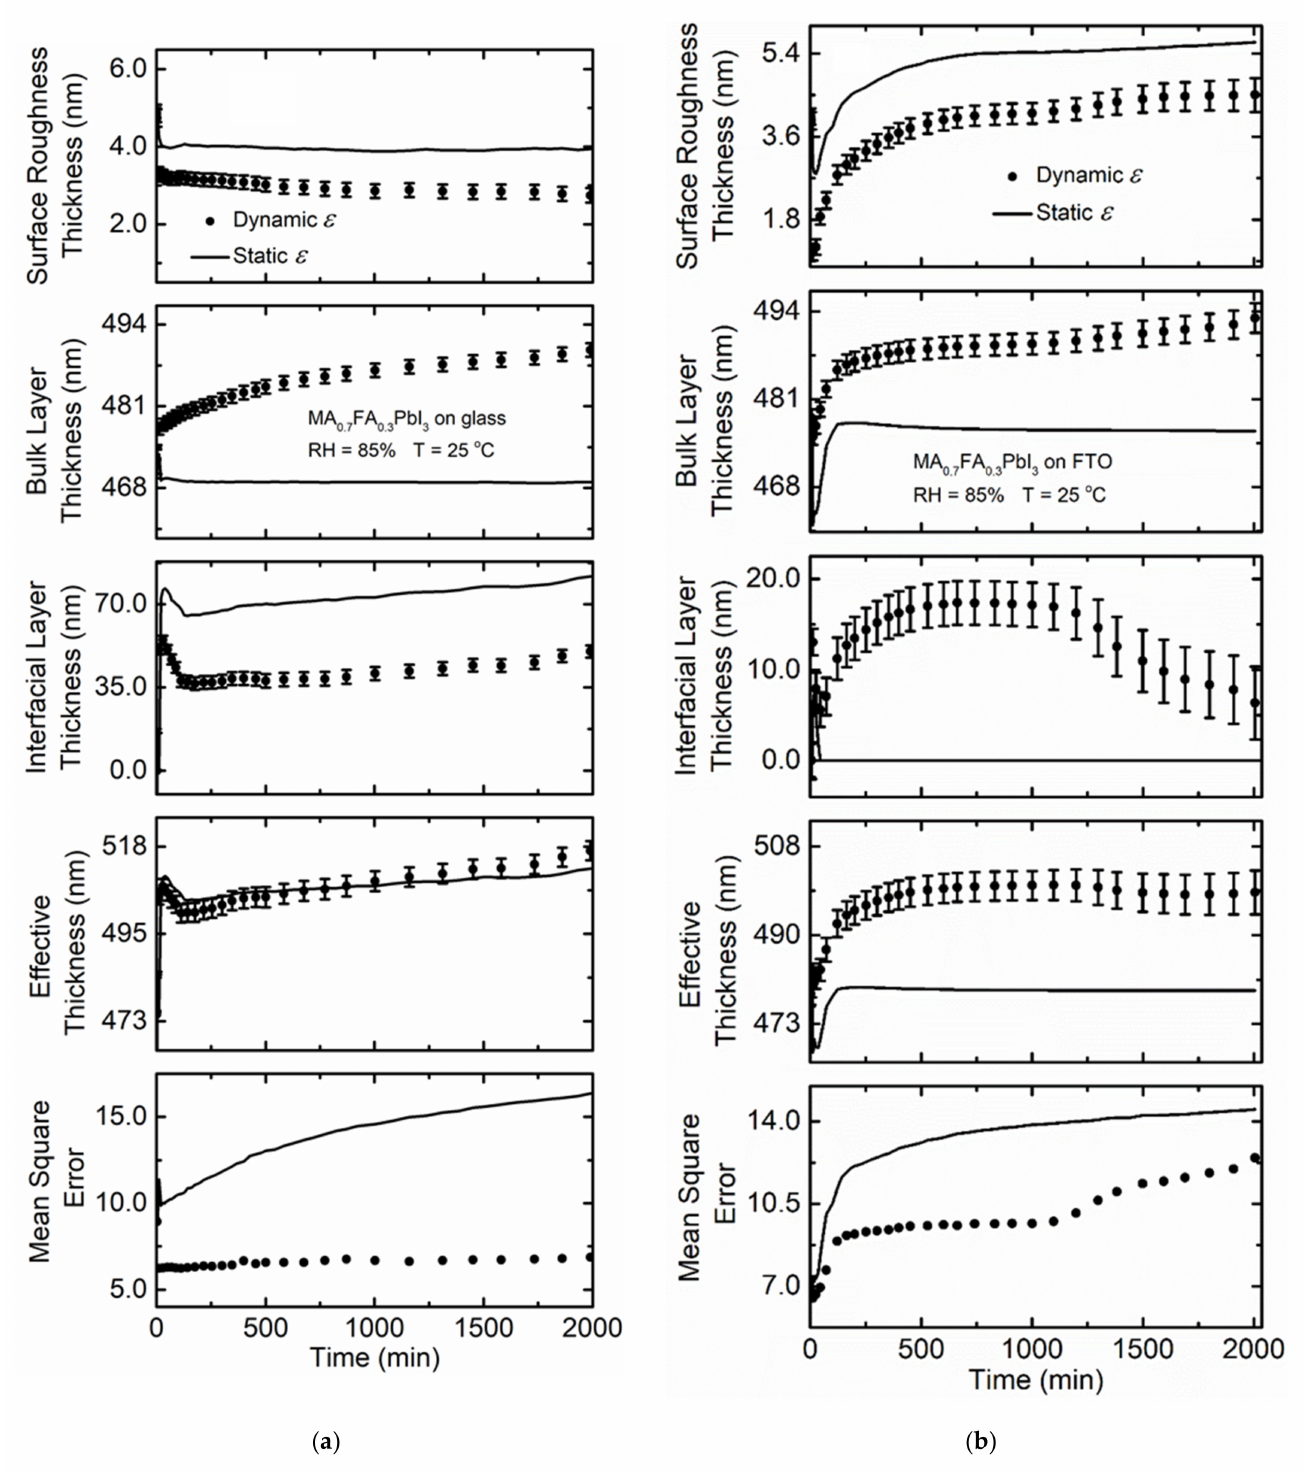
Figure 5. Surface roughness thickness, bulk layer thickness, interfacial layer thickness, effective perovskite thickness, and the quality of fit between the model and experimental ellipsometric spectra in the term of mean square error as functions of time for thin film MA 0.7 FA 0.3 PbI 3 on ( a ) soda lime glass and ( b ) FTO coated glass when exposed to 85% RH at 25 ◦ C. Values obtained assuming the initial spectra in ε (time = 0 min; static) prior to exposure are represented by a solid line, and spectra in ε fit at each time point (dynamic) are represented by solid circles. RH is introduced at 4 and 5 min for ( a ) and ( b ),